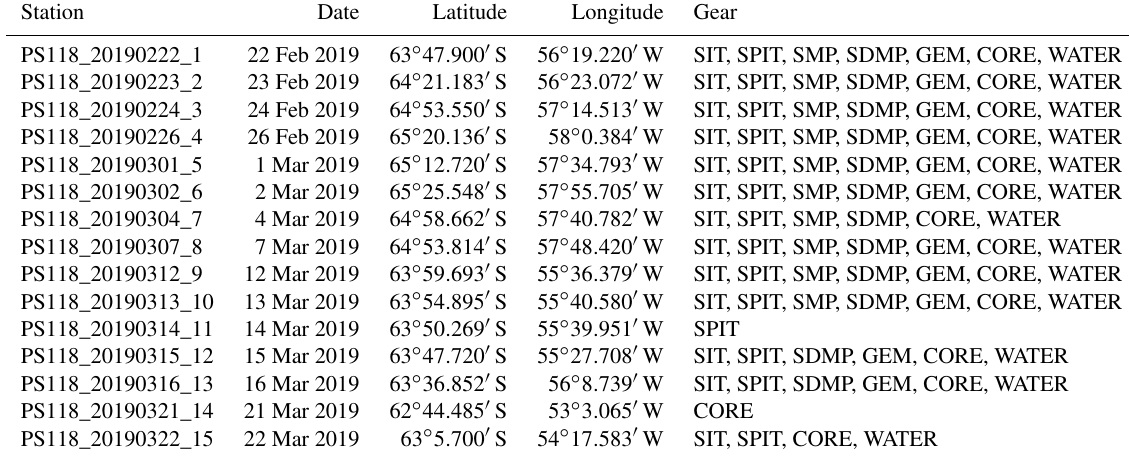
Table B1. List of all sea ice stations within the WedIce project during PS118. The ice station names are composed of the respective date and a consecutive station number. Abbreviations for the gear used at each station are given as follows: SIT – manual sea ice thickness drillings, SPIT – snow pit, SMP – SnowMicroPen, SDMP – snow depth measured with Magna Probe, GEM – sea ice thickness measured with ground electromagnetic sounding device, CORE – physical and biological ice coring, and WATER – surface water sampling.